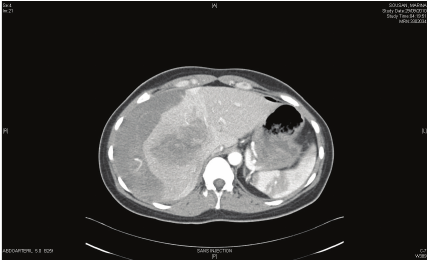
Figure 3: Subcapsular hematoma in abdominal CT scan without